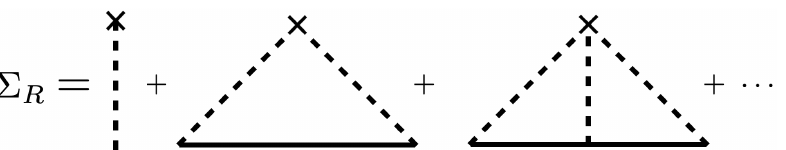
Figure 4. Diagrams contributing to the retarded self-energy Σ R . The solid line corresponds to the free retarded Green’s function, the dashed line the scattering perturbation H 1 , and the × a factor of n d